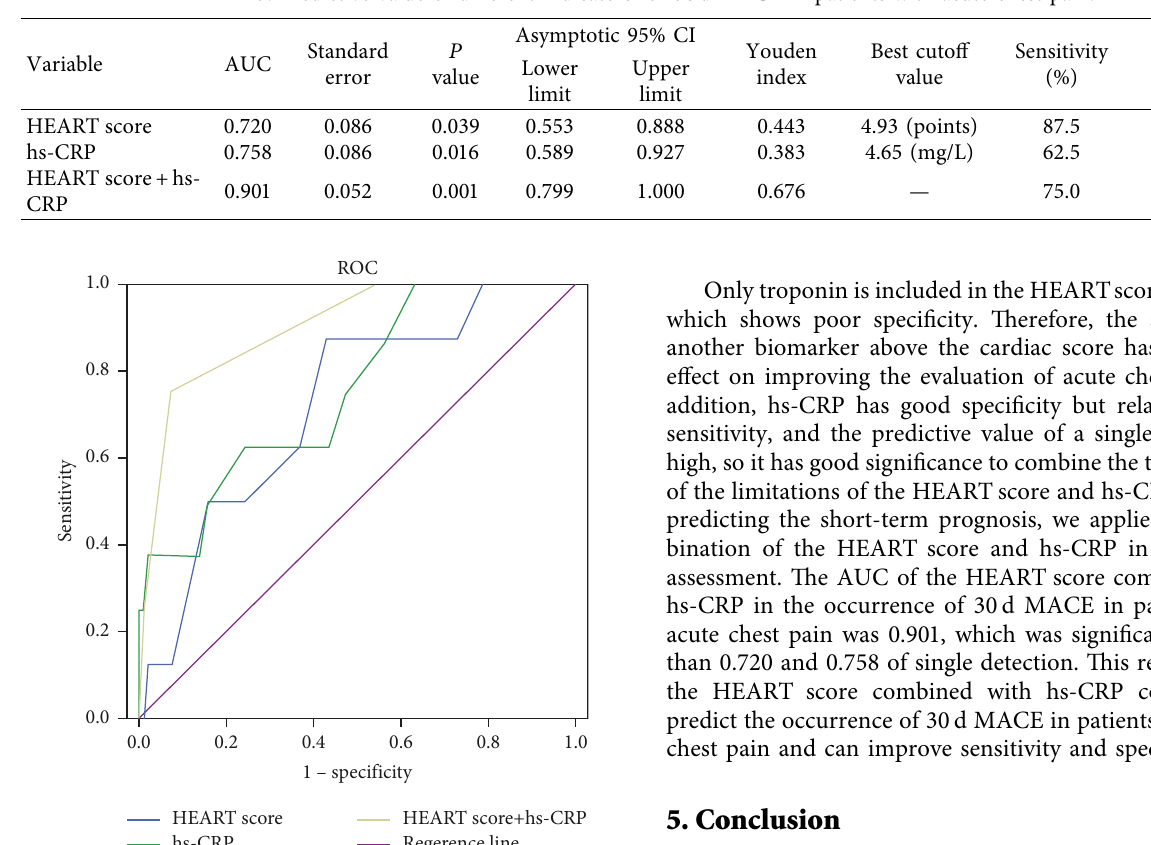
Table 5: Predictive value of diferent indicators for 30d MACE in patients with acute chest pain.